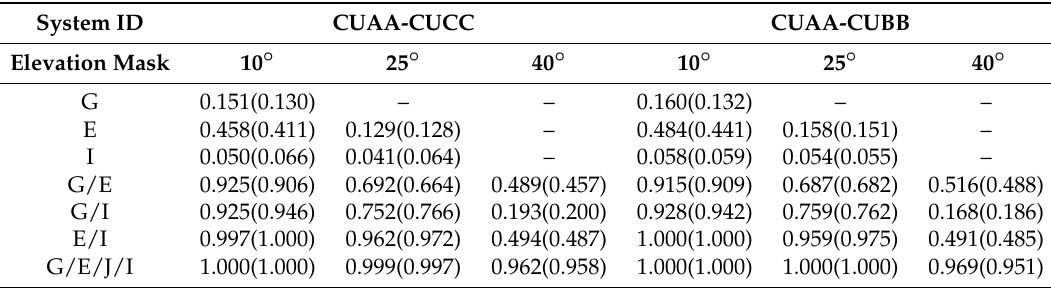
Table 2. Empirical and average formal IB ASRs (in brackets). The data of baseline CUAA-CUCC and CUAA-CUBB on DOY 224, 2018 was